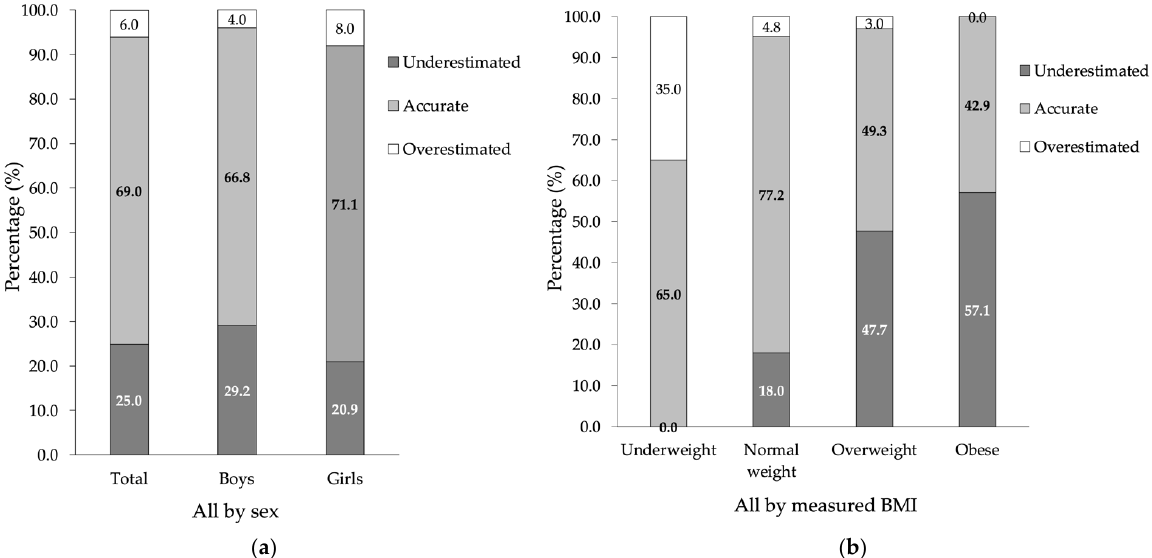
Figure 2. Comparison between measured BMI and parental perception of children’s body weight. ( a ) Accuracy of parental perception of children’s body weight by sex; ( b ) Accuracy of parental perception of children’s body weight by measured BMI.